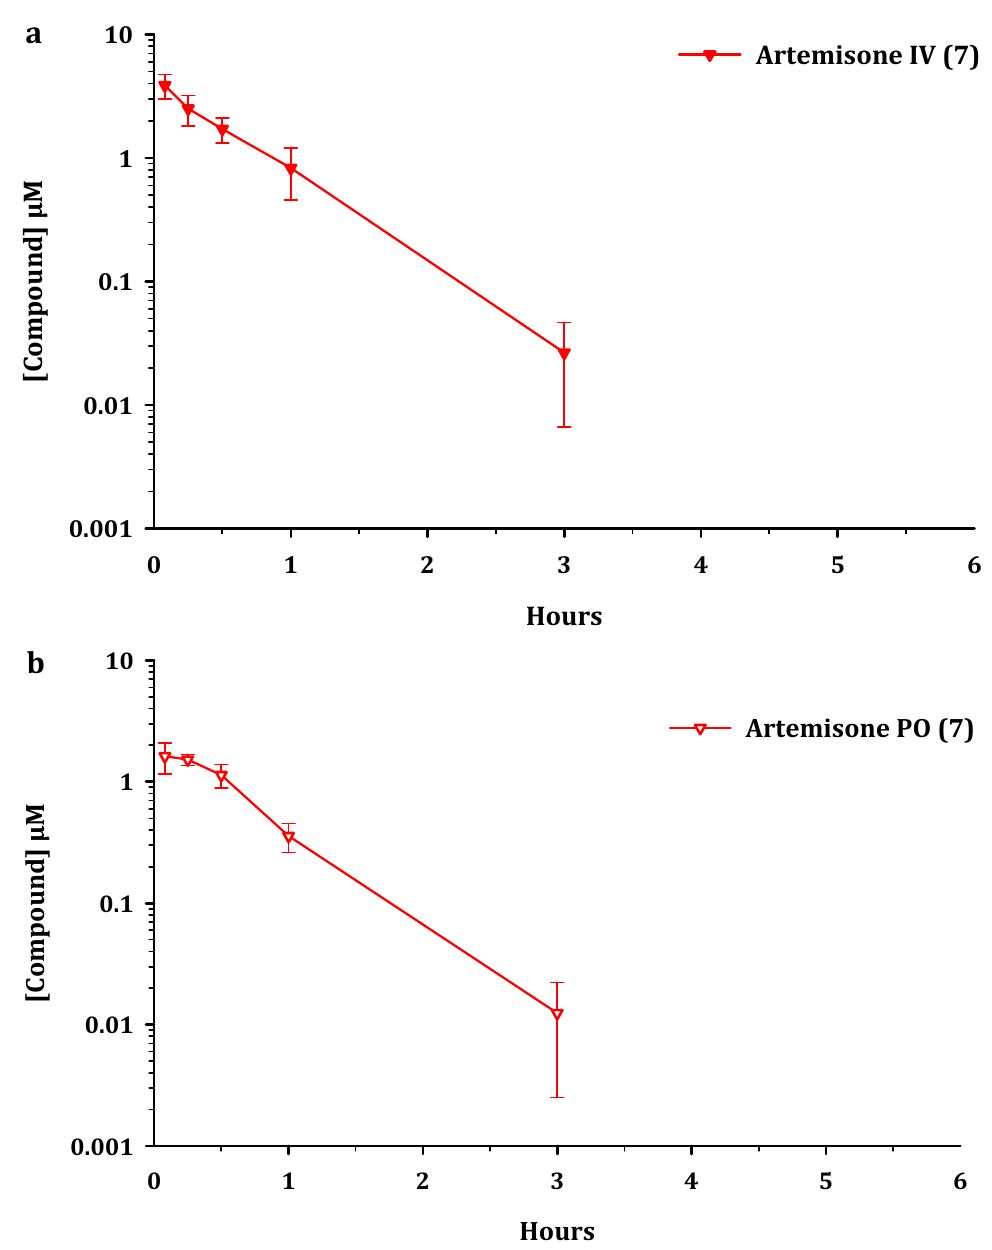
Figure 4. Circulating concentrations of artemisone 7 after ( a ). intravenous ( iv ) administration of artemisone at 5 mg/kg and ( b ). oral ( po ) administration at 50 mg/kg to male C57/BL6 mice ( n = 3 for each group). All results are presented as mean ± standard deviation.